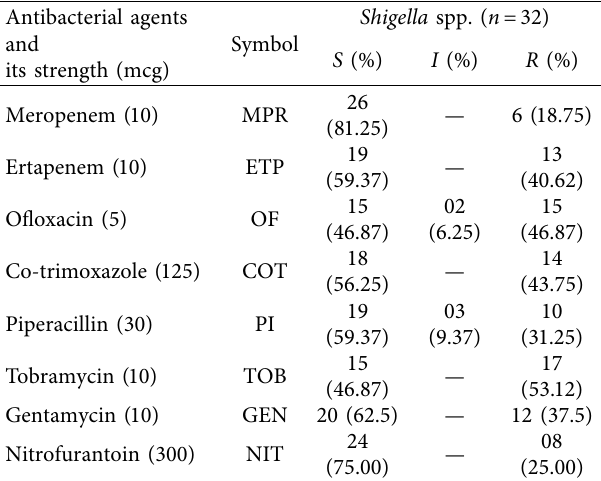
Table 1: Antimicrobial susceptibility profles of E. coli at the Wolaita Sodo University wastewater treatment plant.